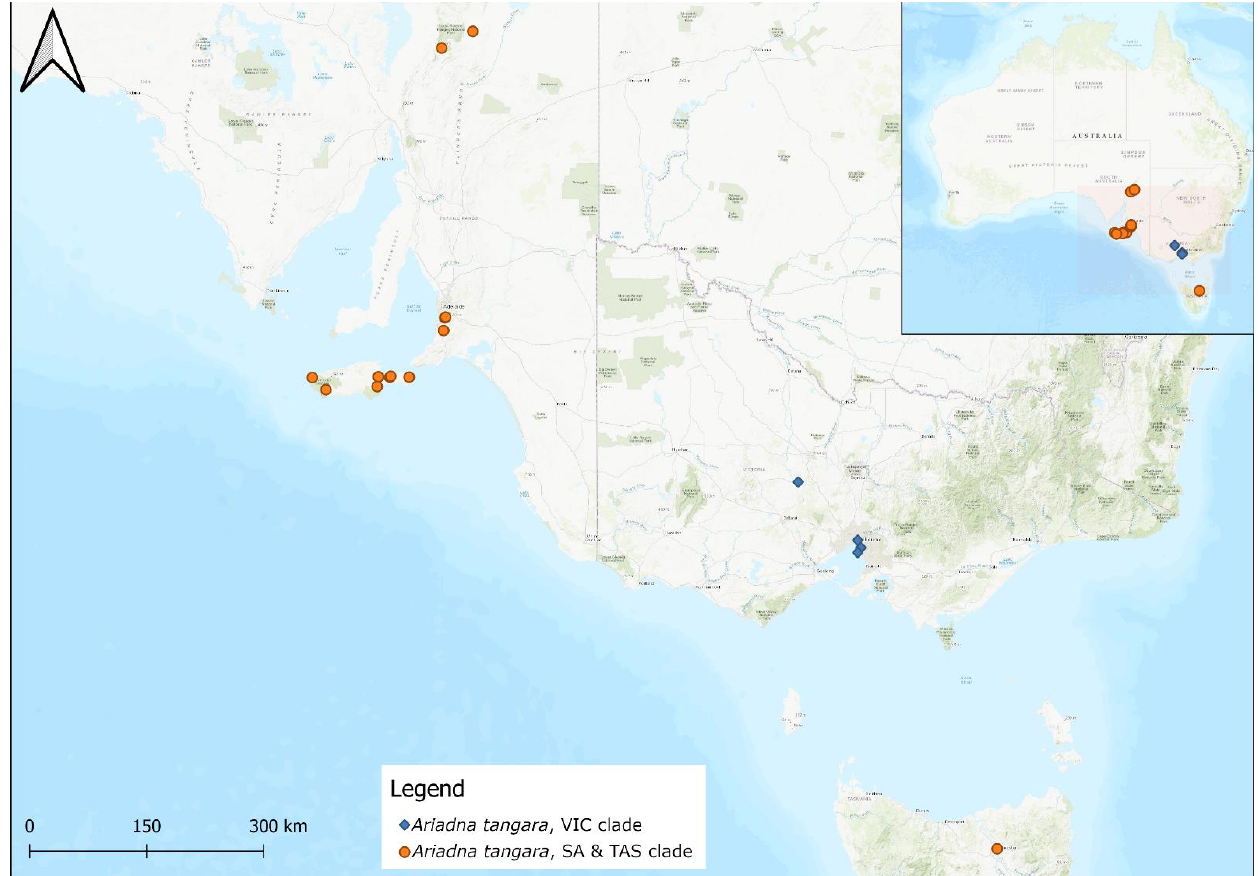
Figure 61. Map showing the currently known distribution A. tangara , illustrating the distribution of the Victorian clade and the South Australian and Tasmanian clade . Ariadna una sp.